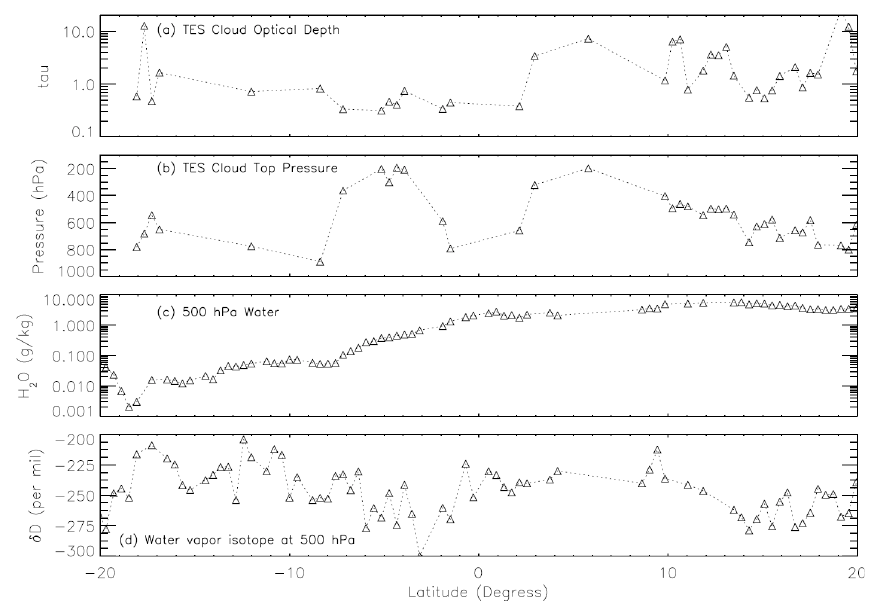
Fig. 3. The TES observations of (a) effective COD, (b) CTP, (c) water vapor amount at 500hPa, and (d) isotopic composition of water vapor at 500hPa, corresponding to the orbit shown in Fig. 2. Only cloudy conditions are presented in (a) and (b)